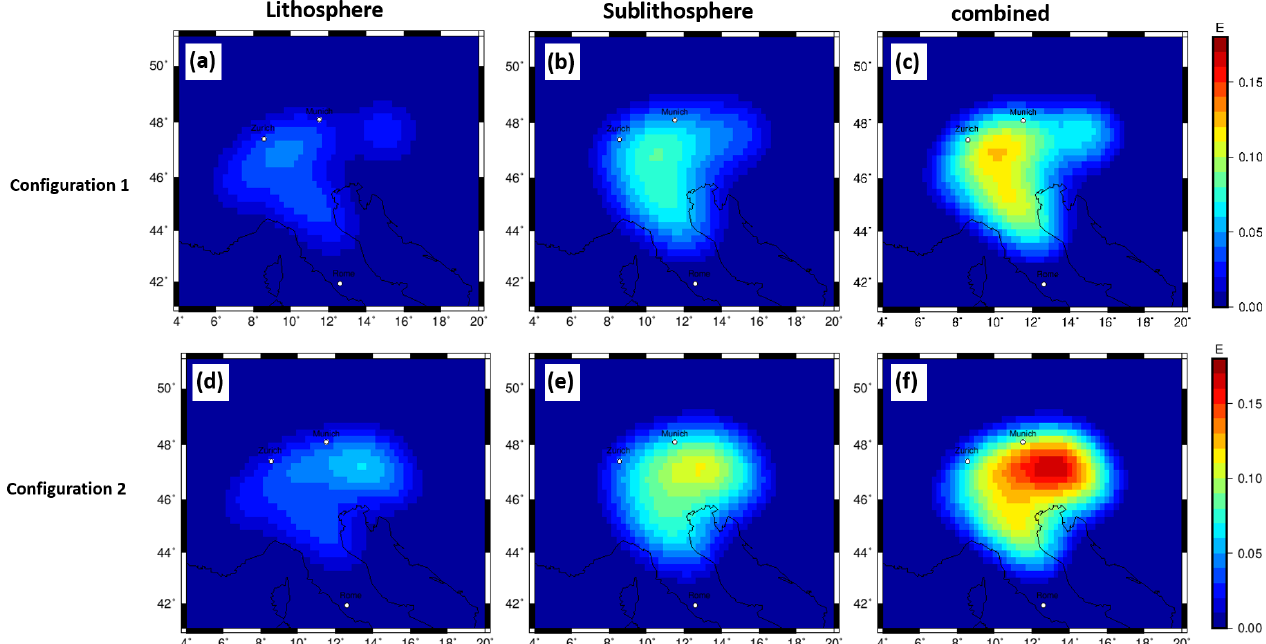
Figure A5. Forward-calculated gzz gravity signal at satellite altitude of 225km based on LitMod models with Tecton-like compositions in the lithosphere and PUM and DMM compositions in the sublithosphere ( M 1 , M 2 , M 3 , M 4 ) with an additional thermal anomaly of − 100K for the sublithospheric slab segment, for predefined slab configuration to the background model M 0 . (a–c) Configuration 1. (d–f) Configuration 2. Topographic and crustal effects are nullified.